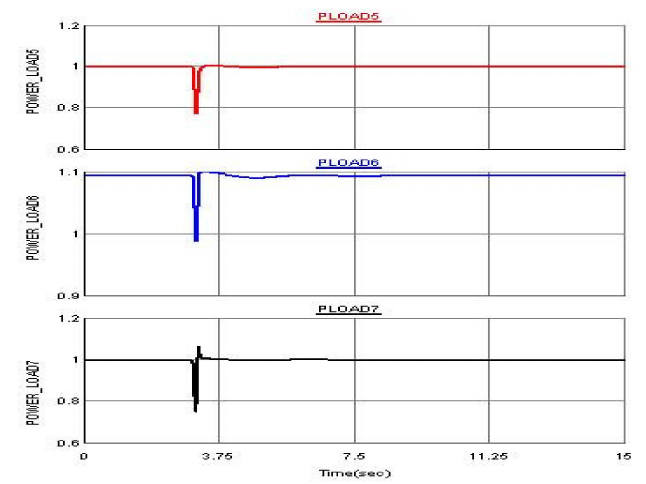
Figure 20. The generated active powers from PV, wind and diesel generator.